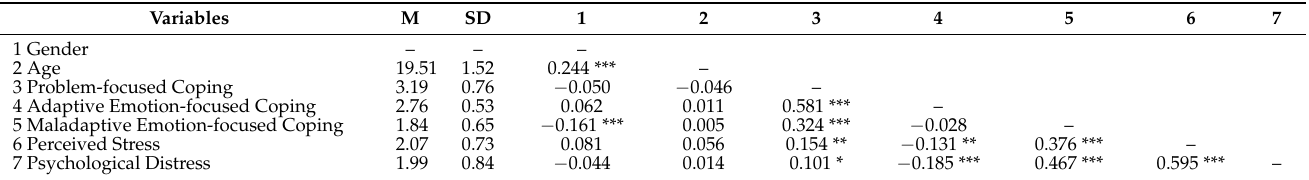
Table 1. Means, Standard Deviations, and Correlations Among the